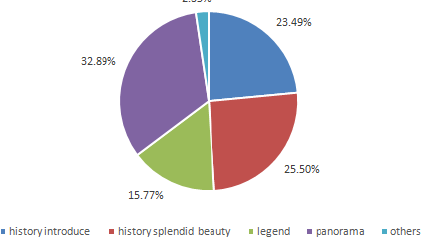
Figure 1: Visitors expectations when touring Yuan Ming Yuan